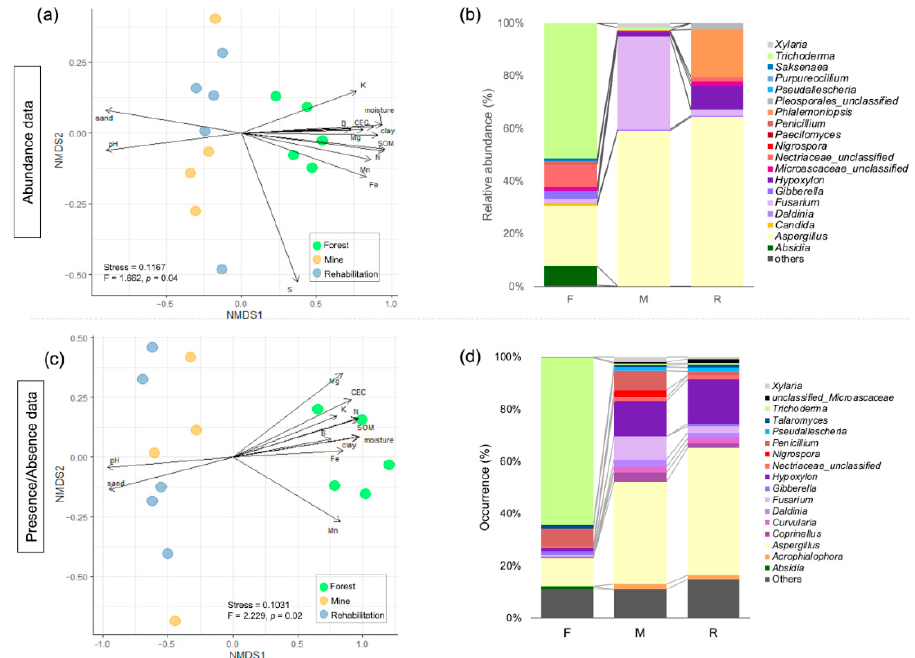
Figure 2. Fungal diversity and taxonomic distribution across three study sites, including forest (F), mining (M), and rehabilitation plots (R): fungal community compositions based on ( a ) Bray–Curtis and ( c ) Jaccard dissimilarity measure and taxonomic distributions based on ( b ) abundance and ( d ) presence/absence data.